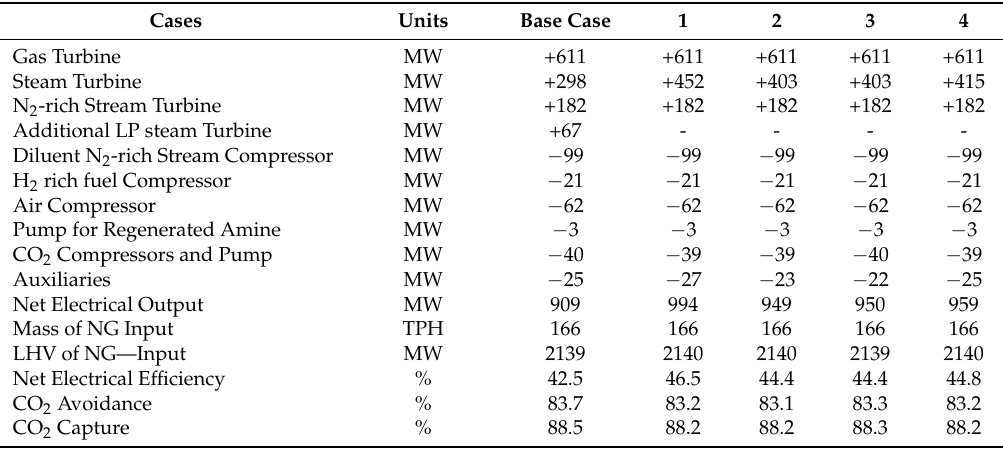
Table 4. Main results for different cases of heat integration